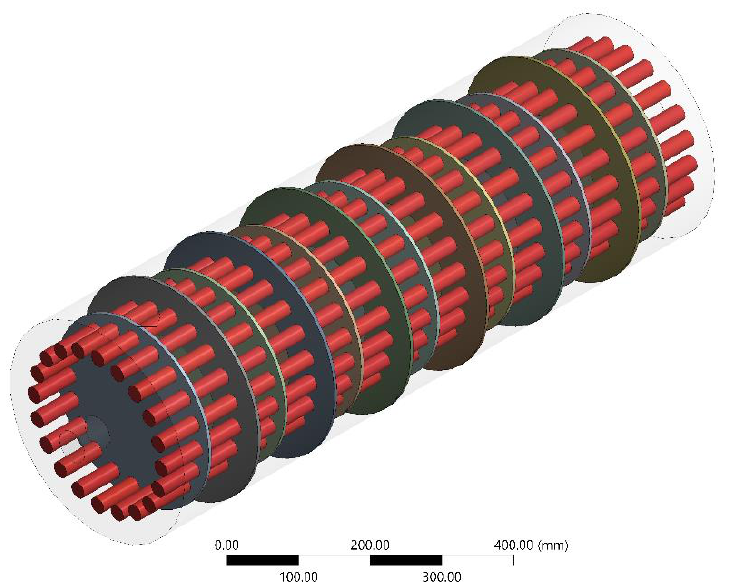
Figure 1. Proposed 1 m reactor module for biogas methanation (case study).